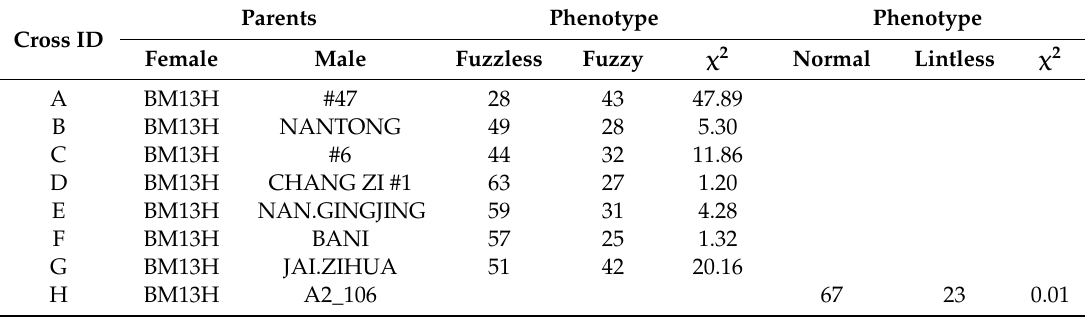
Table 1. Genetic analysis of the fuzzless and lintless traits in segregating